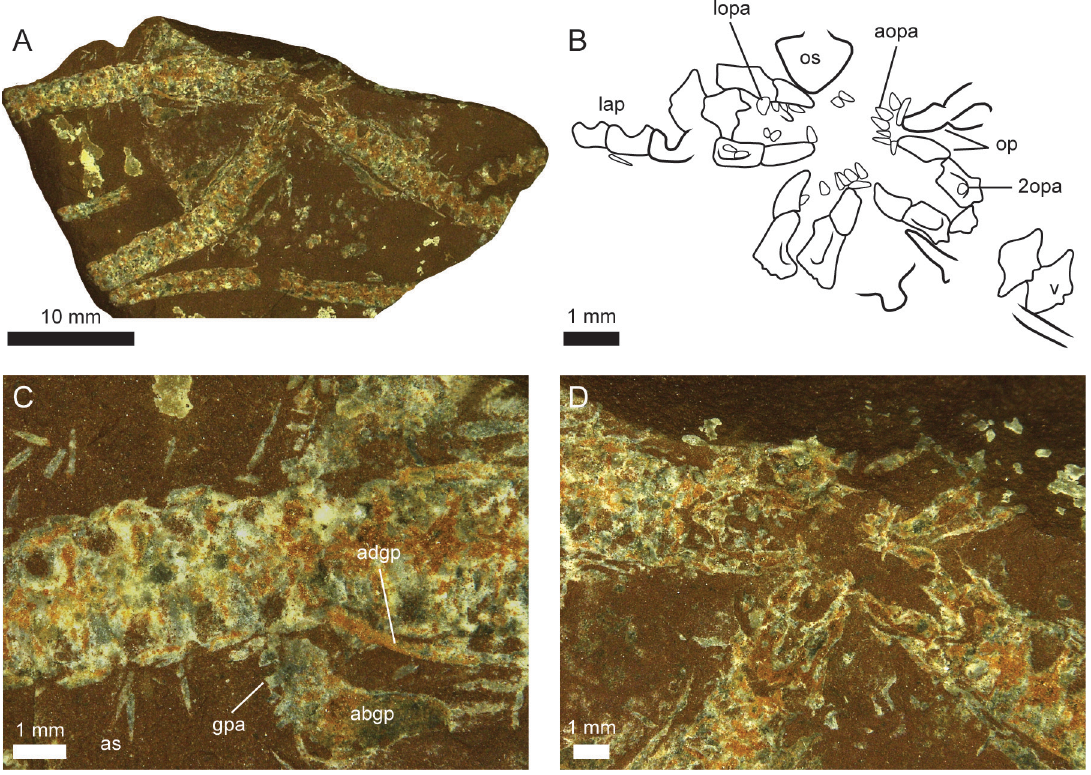
Fig. 6. Ophioculina hoybergia Rousseau & Thuy gen. et sp. nov., holotype PMO 217.930. A . Specimen preserving the ventral side of about half of the disc area and the proximal section of three arms. B . Drawing detail of the oral region, from D. C . Detail view of the base of an arm showing the arm comb. D . Detail view of the oral region. Abbreviations: abgp = abradial genital plate; adgp = adradial genital plate; aopa = apical oral papilla; as = arm spine; gpa = genital papilla; lap = lateral arm plate; lopa = lateral oral papilla; op = oral plate; os = oral shield; v = vertebra; 2opa = papilla of the second oral tentacle